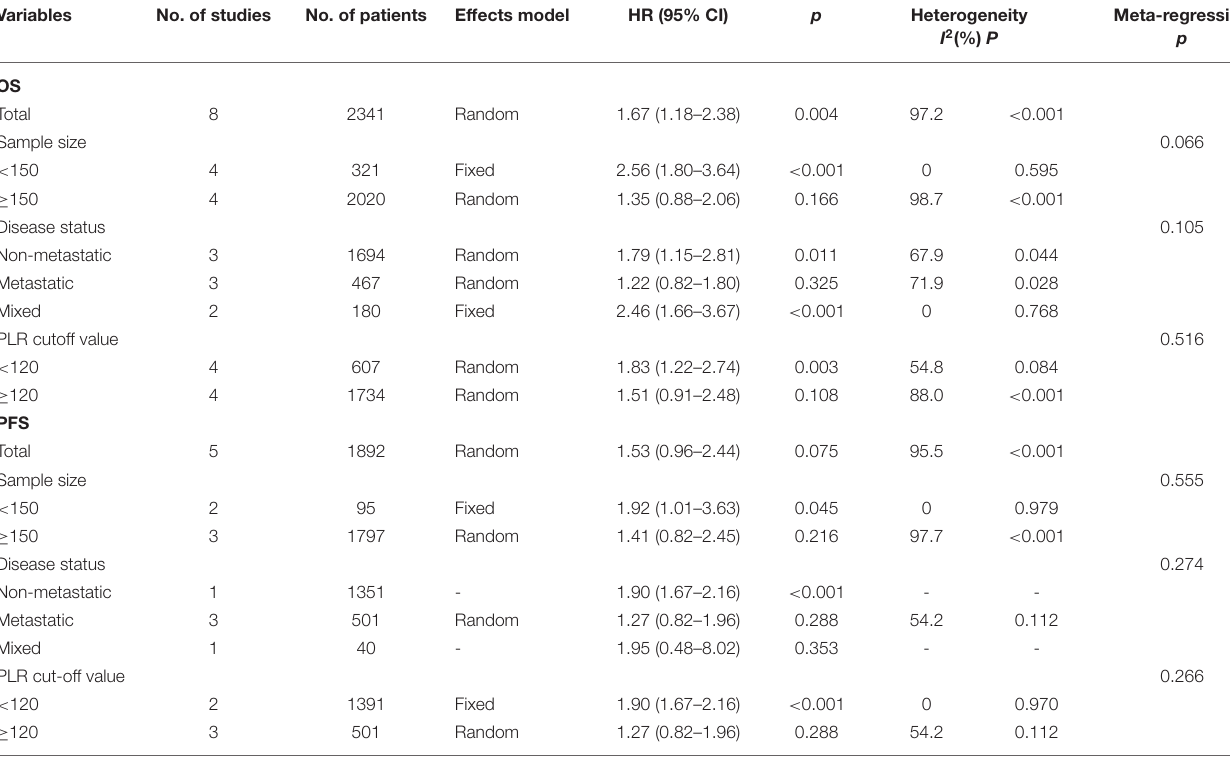
TABLE 2 | The subgroup analysis between PLR and the prognosis of patients with melanoma.